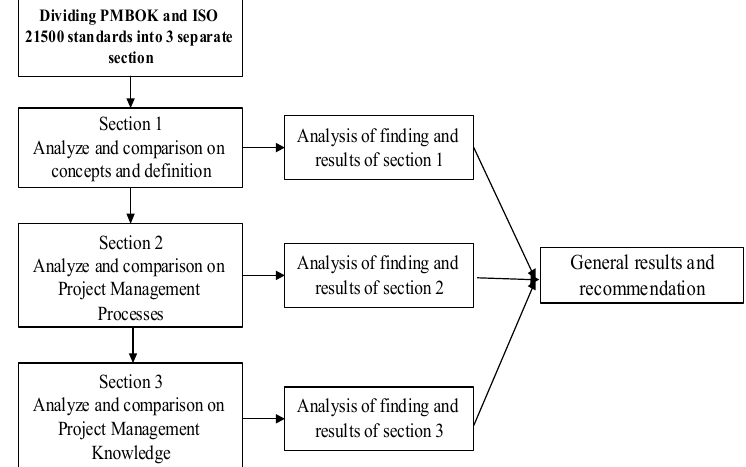
Fig. 1. Research systematic